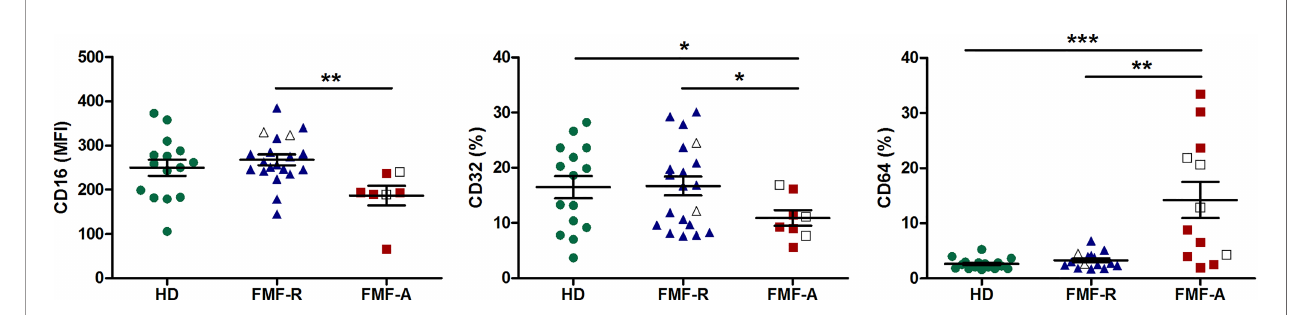
FIGURE 3 | SurfaceexpressionofFc g RIII(CD16), Fc g RII(CD32), Fc g RI(CD64) oncirculatingPMNsfrom HD,FMF-RandFMF-A patients.* p <0.05; ** p < 0.01;*** p